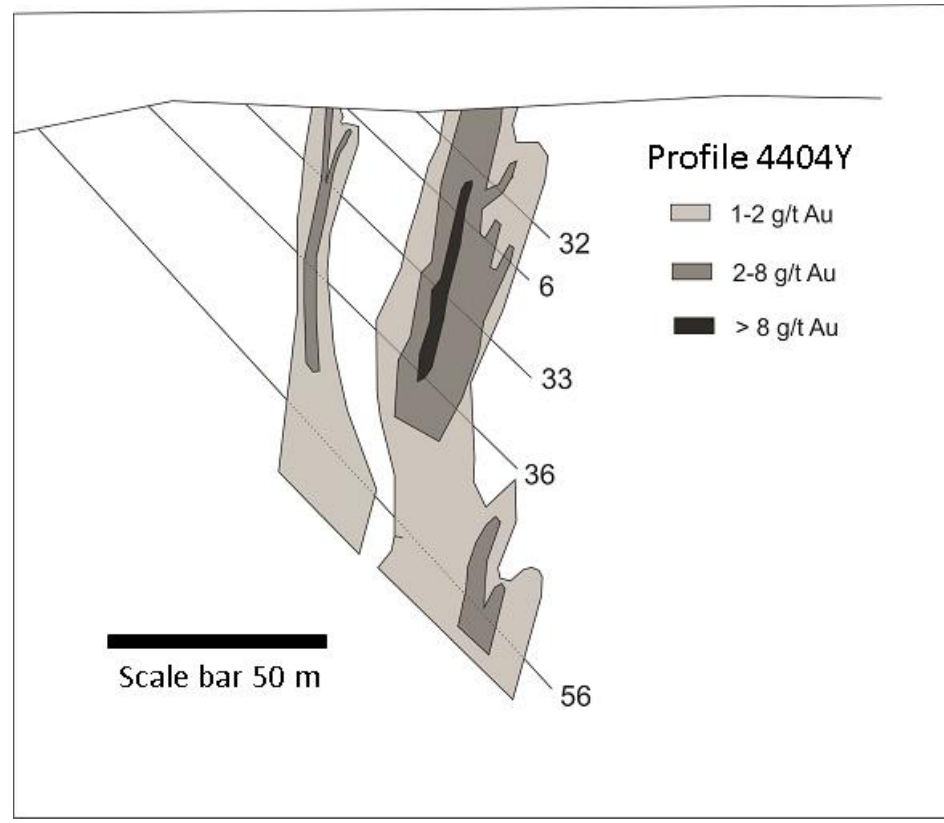
Figure 7. Gold zonation along a vertical